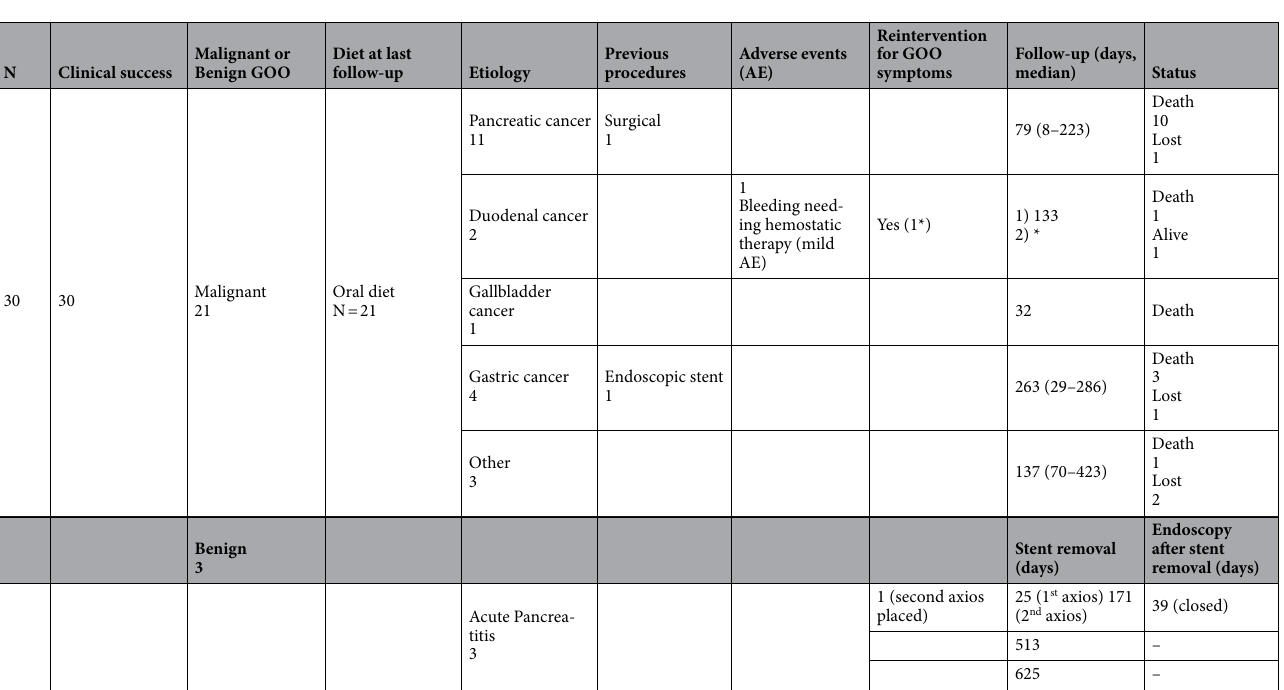
Table 3. Characteristics and outcomes of EUS gastroenterosomies. Other: pylorus, ectopic pancreas, lymphoma. *Correspond to the last patient described in results: intentional removal of the stent led to the closure of the fistula and a surgical gastroenteroanastomosis was required. She is currently